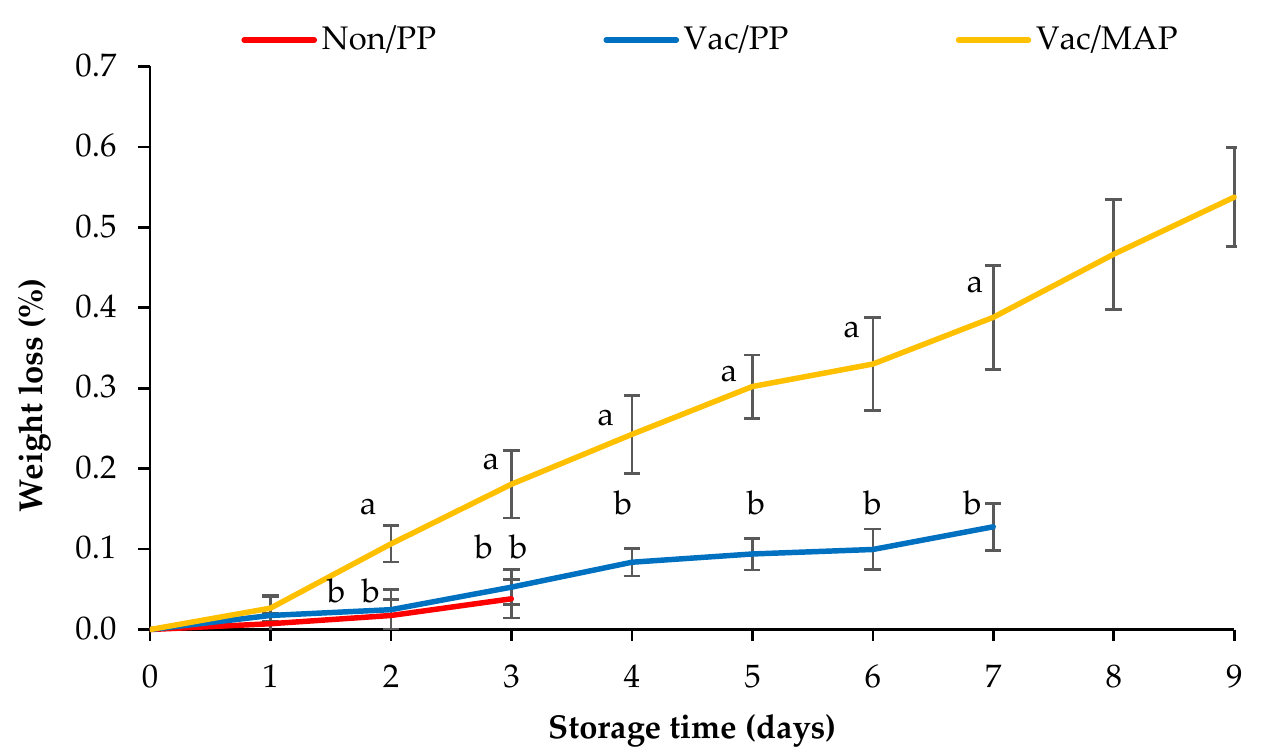
Figure 5. Changes in weight loss percentage of the whole packaged fresh-cut vegetables during storage at 4 °C. Error bars represent the mean of three replicates ± SD.